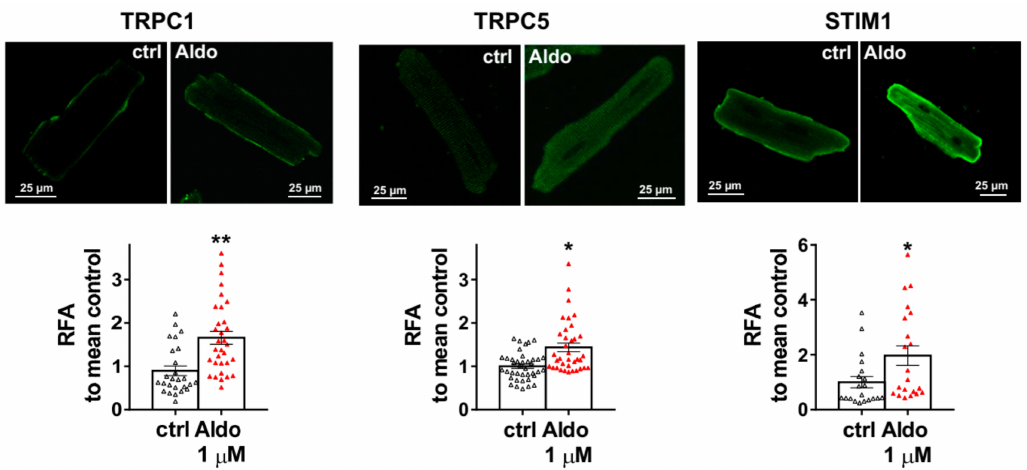
Figure 4. Cellular localization of TRPC1, TRPC5, and STIM1 in ARVMs. Representative immunofluorescences images (top) and quantification of TRPC1, TRPC5, and STIM1 in ARVMs incubated for 24 h in the absence or in the presence of aldosterone 1 µ M. Results are expressed as relative fluorescence / cellular area (RFA). Average results of 20–39 cells from three isolations. Results are presented as scatter plots with mean ± SEM. Statistical significance was evaluated using Student’s